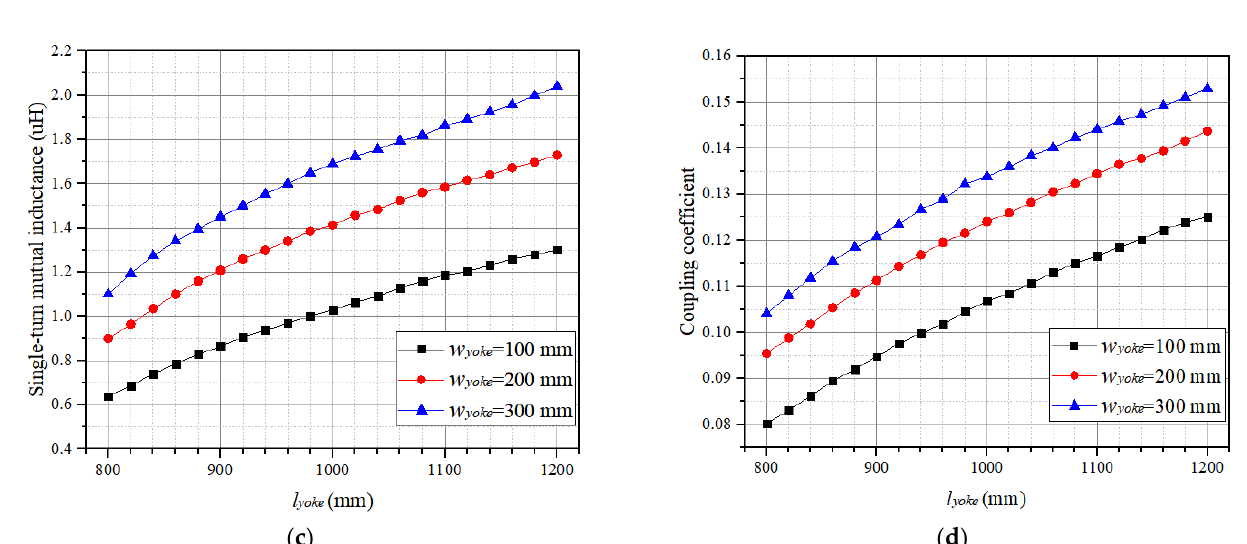
Figure 5. ( a ) The mutual inductance and ( b ) the coupling coefficient of single-turn winding D in Mode 1, and ( c ) the mutual inductance and ( d ) the coupling coefficient of single-turn winding Q in Mode 2.